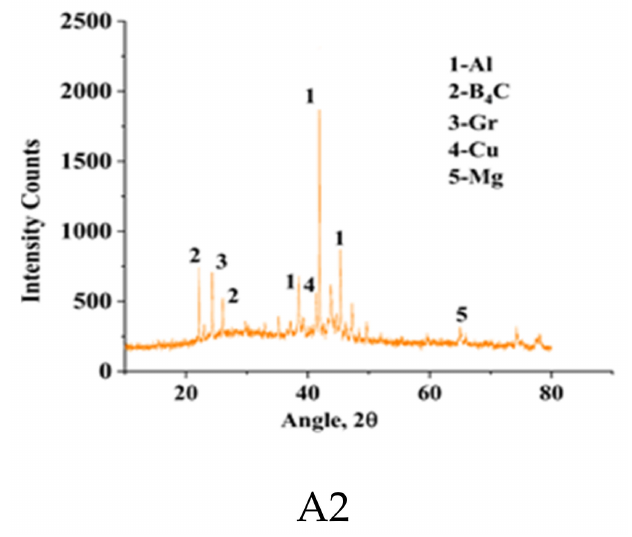
Figure 2. XRD of samples (A0), (A1) and (A2).